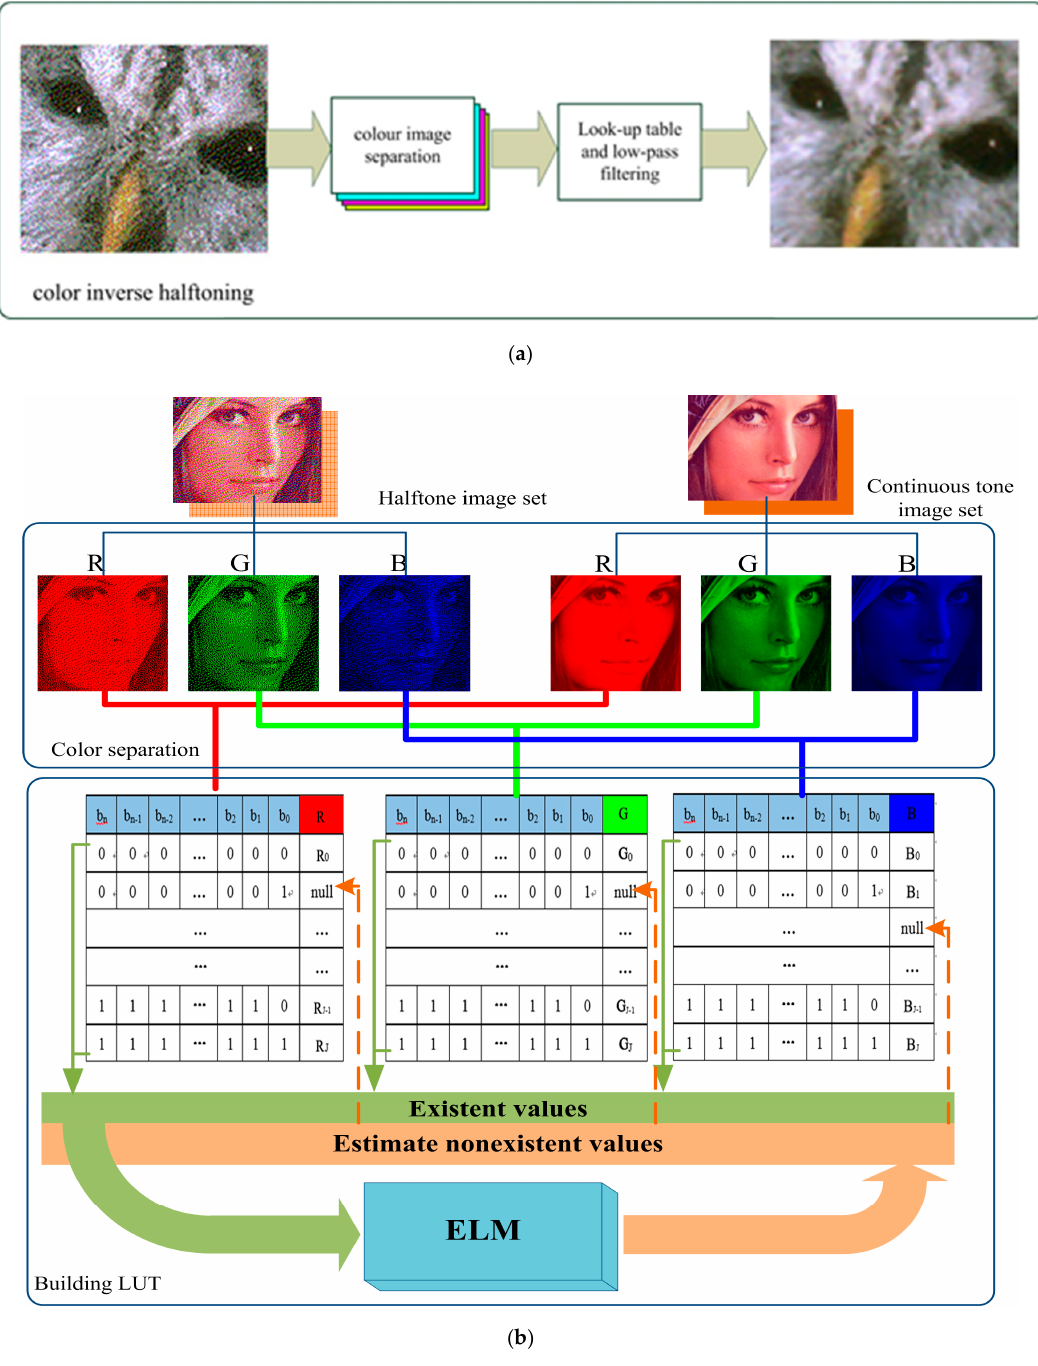
Figure 1. The framework of our proposed color inverse halftoning method by multi-color components correlation, ( a ) the process of inverse halftoning, ( b ) the creation of color look-up table